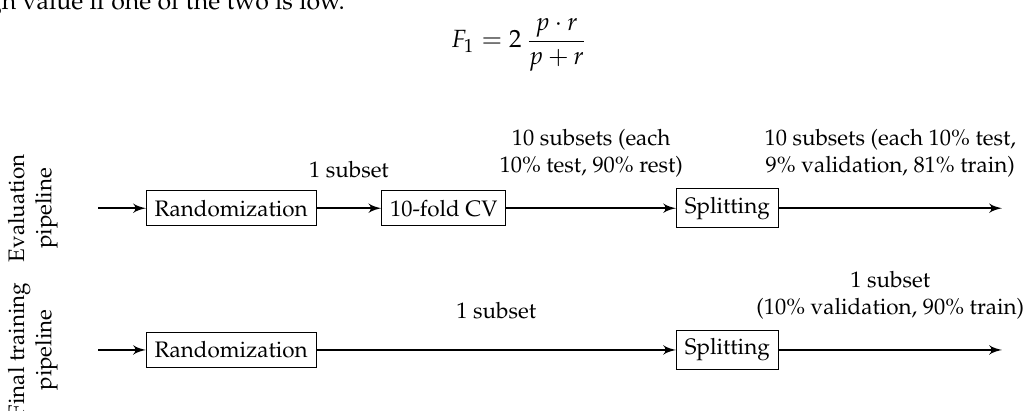
Figure 4. Data splitting pipeline during evaluation (top) and final training (bottom). Cross validation (CV) and splitting is always